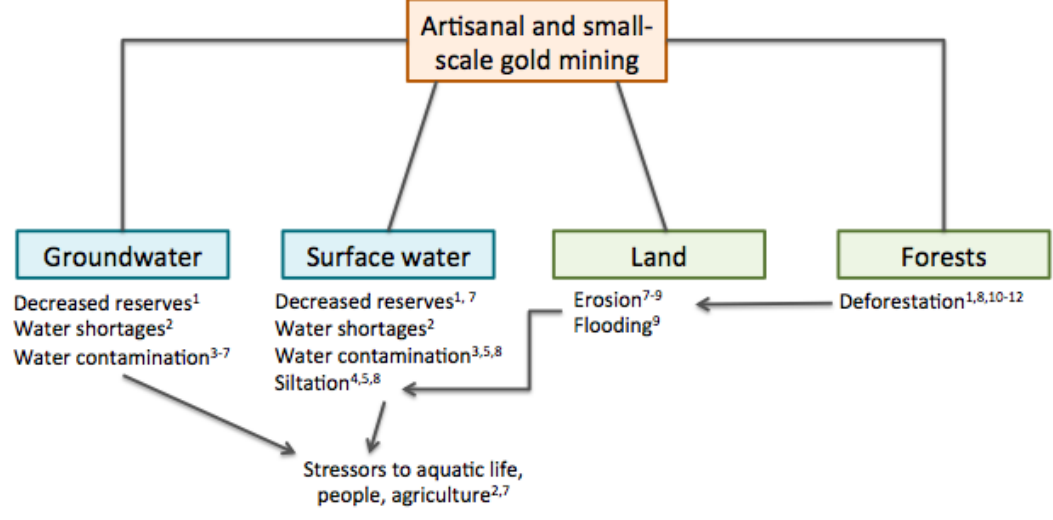
Figure 10. ASGM impacts on water systems. ( 1 Valdivia and Ugaya 2011 [22]; 2 Garvin et al. 2009 [95]; 3 Asante et al . 2007 [57]; 4 Armah et al . 2012 [92]; 5 Long et al